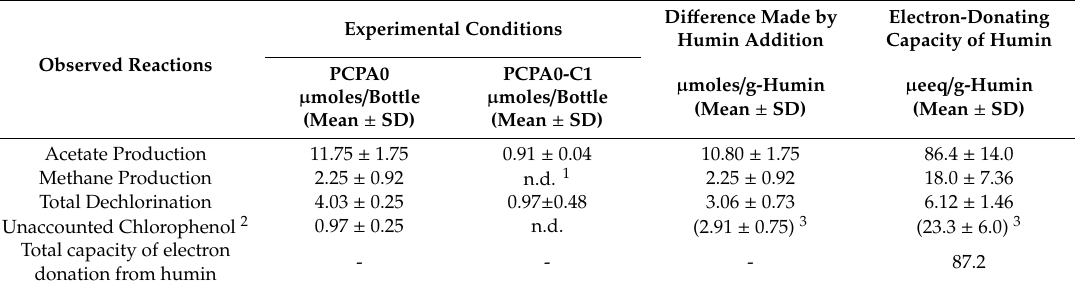
Table 2. Metabolites produced by the consortium PCPA0 and the estimated electron-donating capacity of humin (1g /